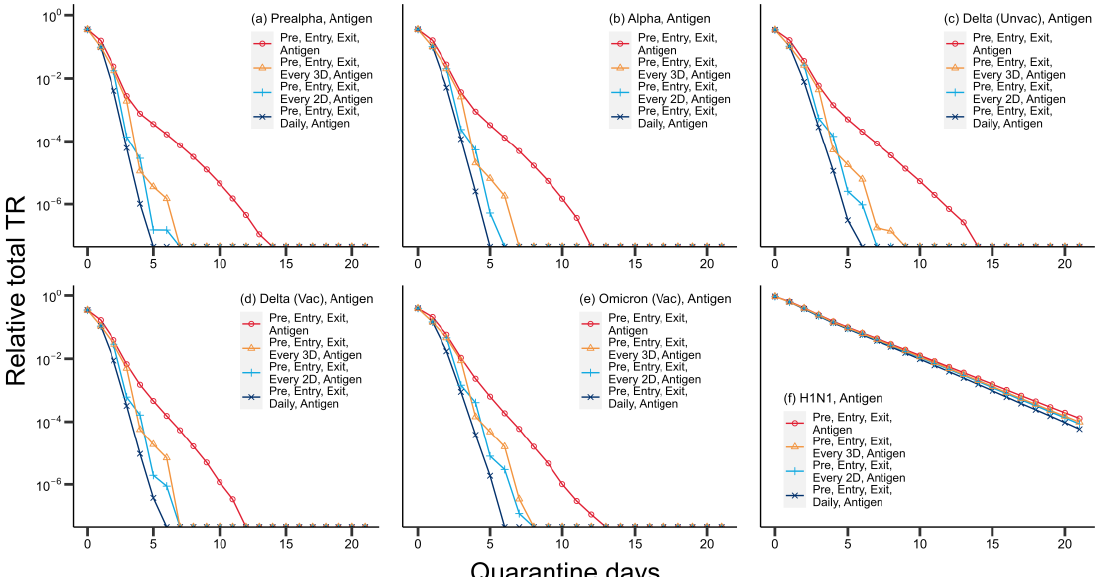
Figure 5. Mean relative total TR for ART-based strategies by virus variant: ( a ) prealpha, ( b ) alpha, ( c ) delta unvaccinated, ( d ) delta vaccinated, ( e ) omicron vaccinated and ( f ) influenza A-H1N1. Strategies include the following: pretesting, entry testing and exit testing (red with circles); pretesting, entry testing, testing every three days in quarantine and exit testing (orange with triangles); pretesting, entry testing, testing every two days in quarantine and exit testing (light blue with ticks);